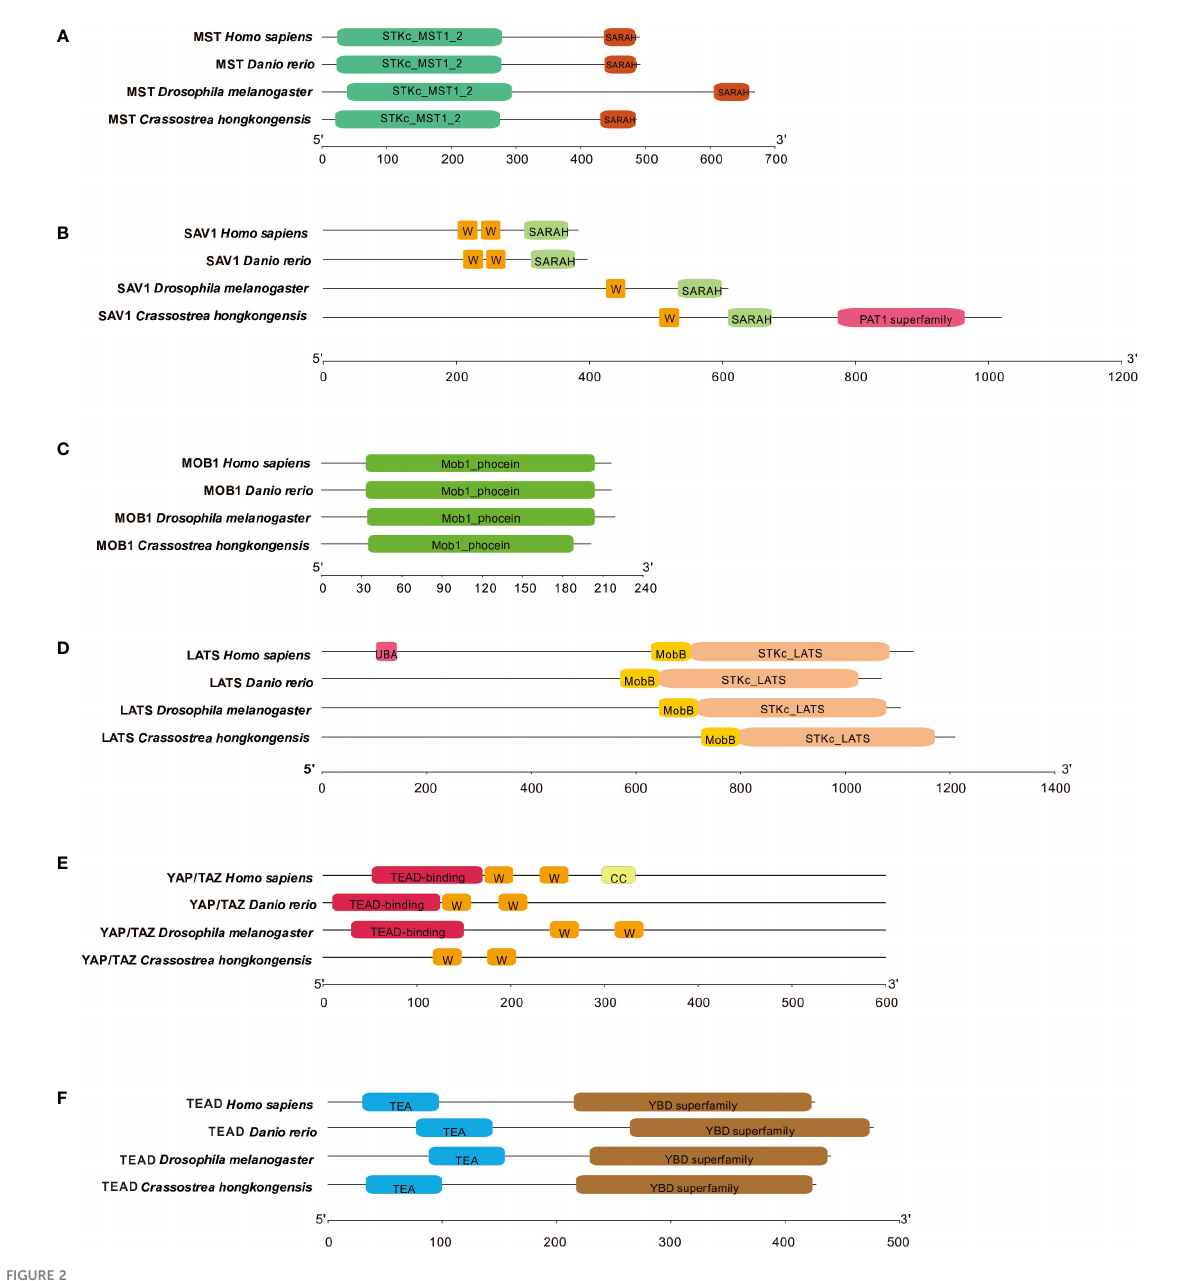
FIGURE 2 Domain characteristics of ChMST (A) , ChSAV1 (B) , ChMOB1 (C) , ChLATS (D) , ChYAP/TAZ (E) and ChTEAD (F)